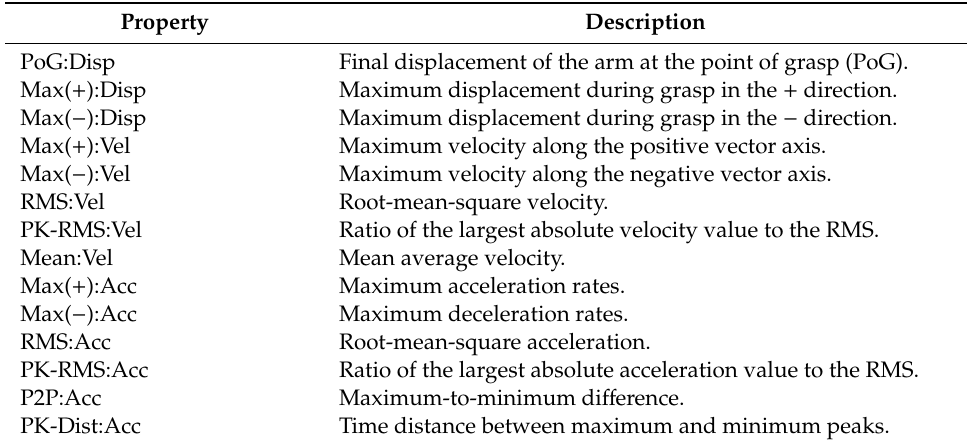
Table 2. Kinematic feature space.